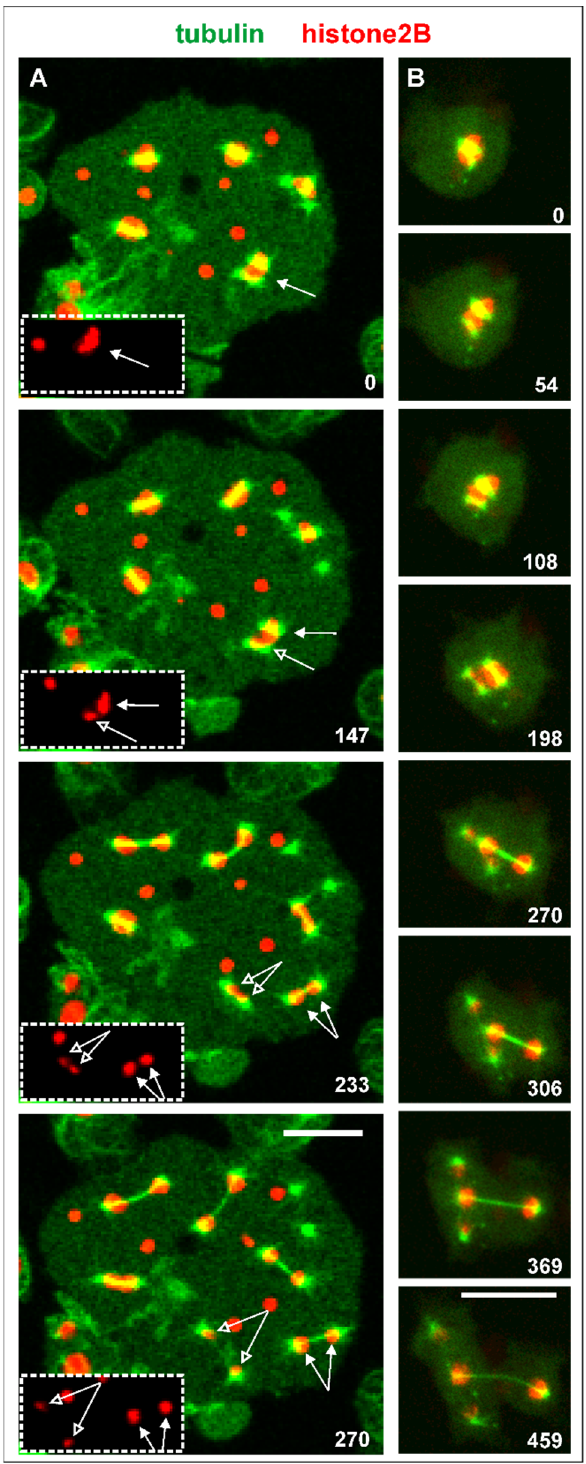
Figure 5. Mitotic complexes with incomplete sets of chromosomes. Septase-null cells expressed GFP- α -tubulin as a label Figure 2. B for the chromosomes (red). ( A ), mitosis in a multinucleate cell. Two mitotic complexes distinguished by different amounts of histone-labeled material are indicated by closed and open arrows. In the boxed area, these two complexes are displayed in the histone2B channel only. The cell was compressed by agar overlay. ( B ), four centrosomes attached to a large nucleus, forming two spindles that translocated different sets of chromosomes to their poles. The cell is also shown in Video S3. Time is indicated in seconds. Bars, 10 µm.